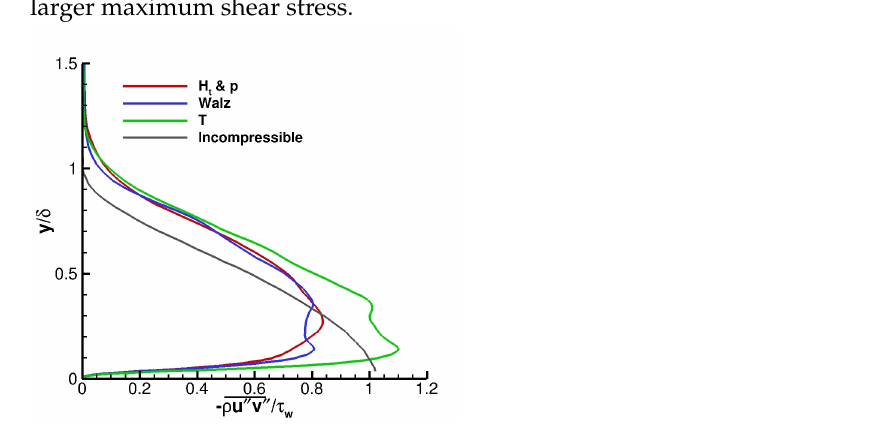
Figure 6. Effect of the recycling-rescaling method on Morkovin scaled dimensionless turbulent shear stress at x / δ = 20 for condition No.